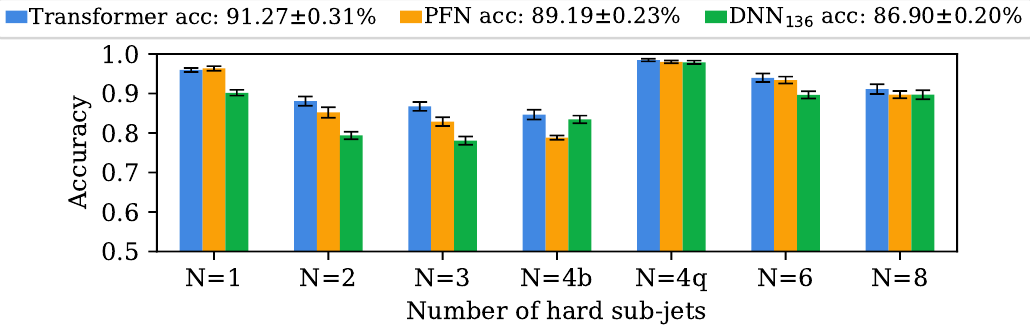
Figure 4 . Mean 10-fold accuracy and statistical uncertainty of the network predictions for jets in each class, for the three network studies.